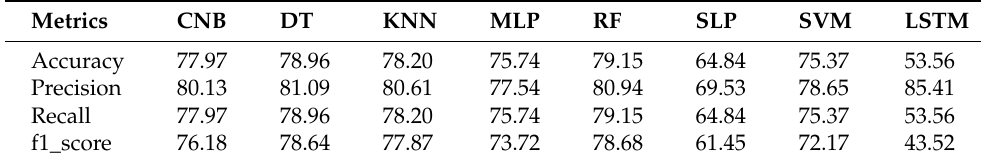
Table 3. Average cross validation score of models.